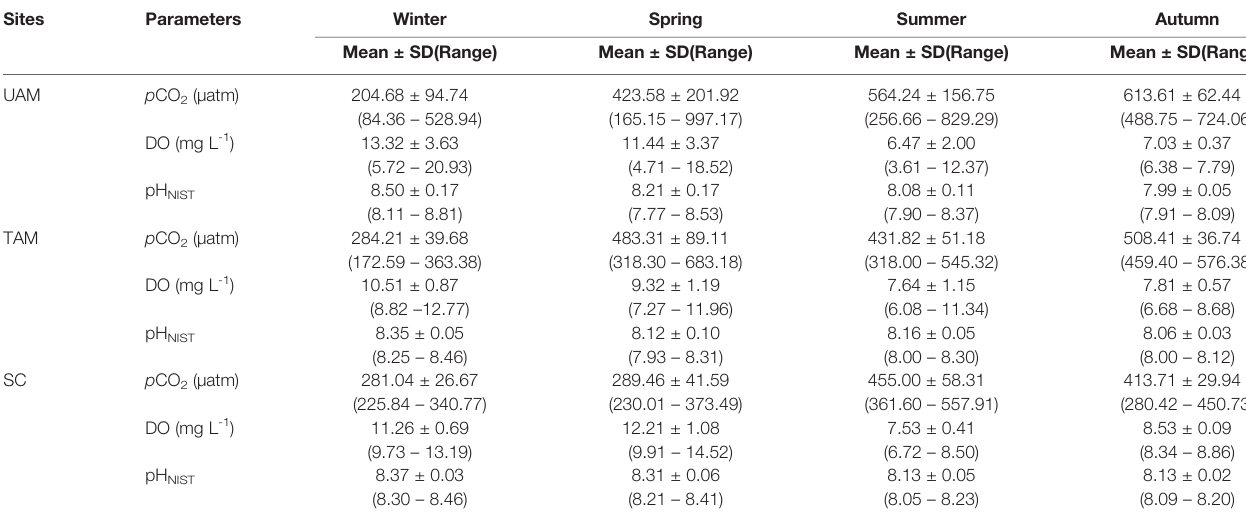
TABLE 4 | The mean ± standard deviation (SD) and variation range of the in-situ monitoring parameters (partial pressure of CO 2 : p CO 2 , dissolved oxygen: DO, and pH on the scale of National Institute of Standards and Technology: pH NIST ) of three macroalgal habitats (UAM: ulvoid algal mat; TAM: turf algal mat; SC: coexisting Sargassum horneri and crustose coralline algae) in four